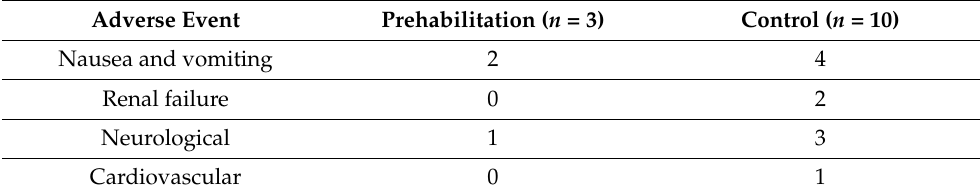
Table 2. Adverse events.